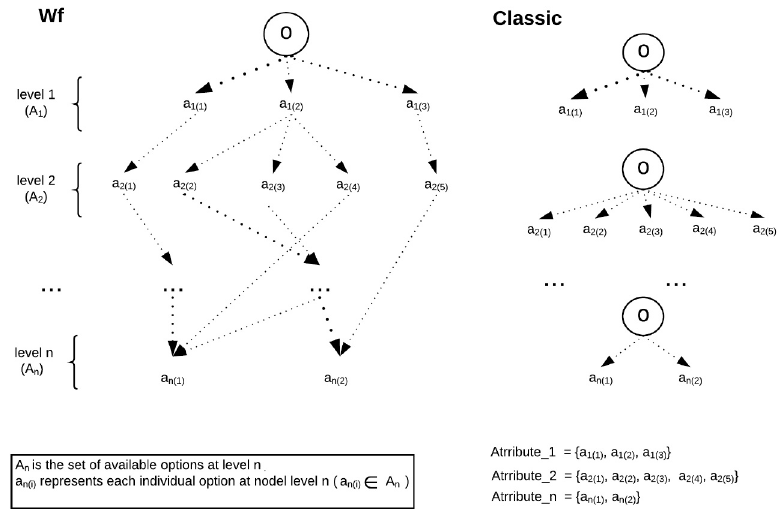
Figure 7. Graph representation of an example classi fi cation work fl ow W f vs the corresponding classic way of looking at the classi fi cation with multiple